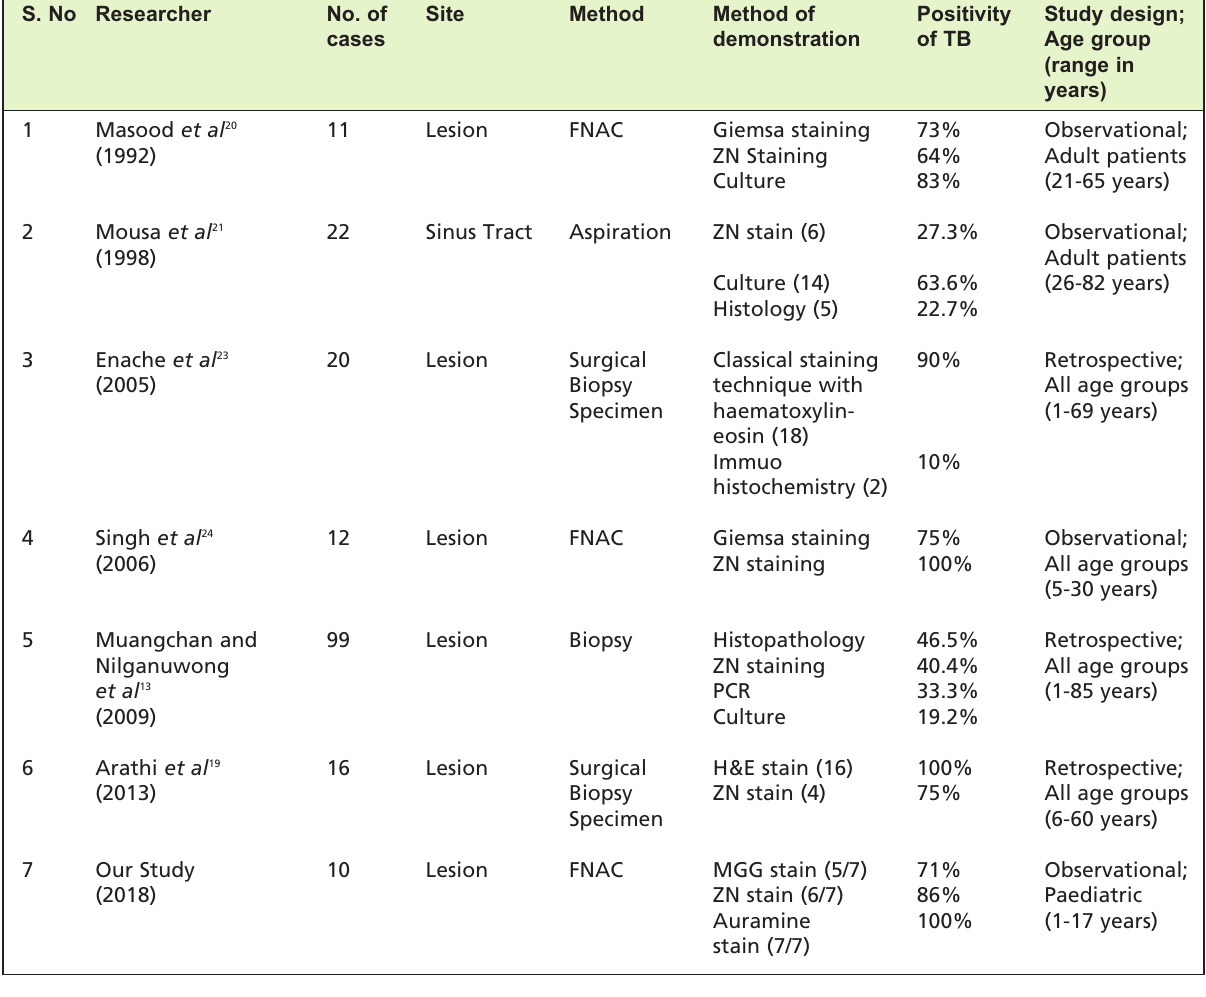
Comparison of different studies for diagnosis of Osteoarticular TB by demonstration of Tubercle Bacilli- Table III: